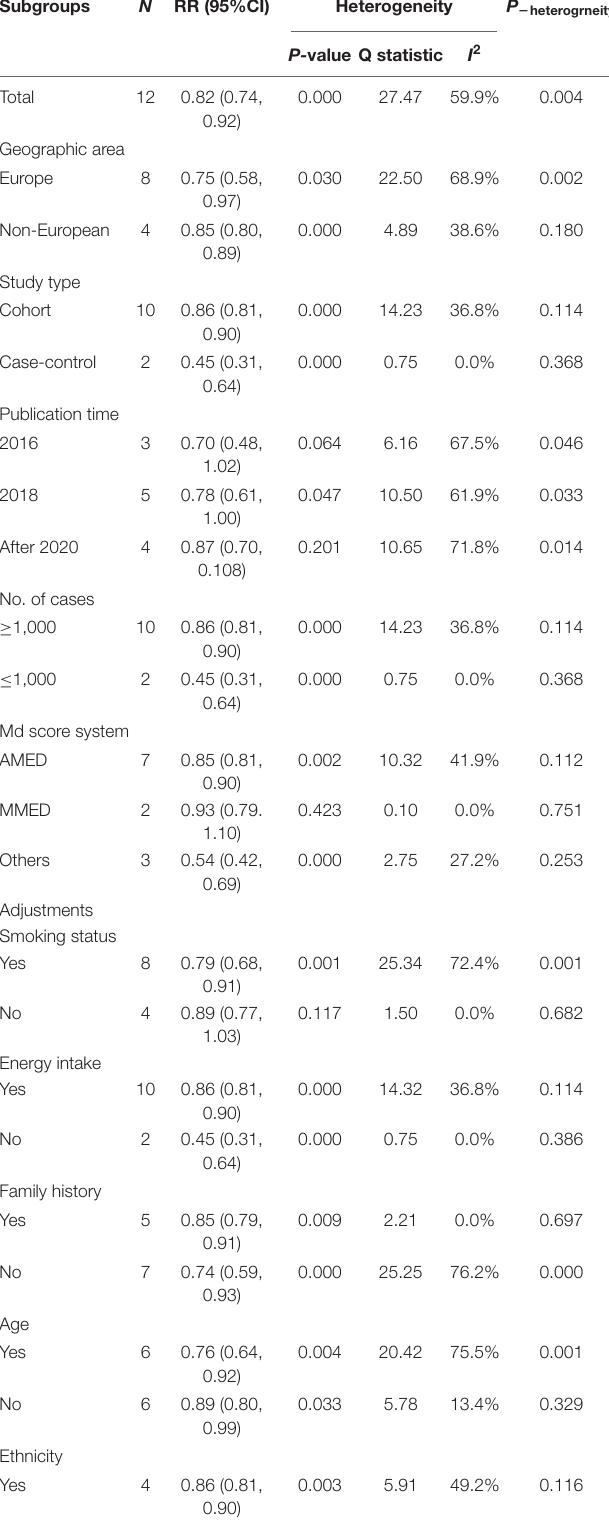
TABLE 3 | Subgroup analysis of the relationship between Mediterranean diet patterns and the risk of lung cancer.